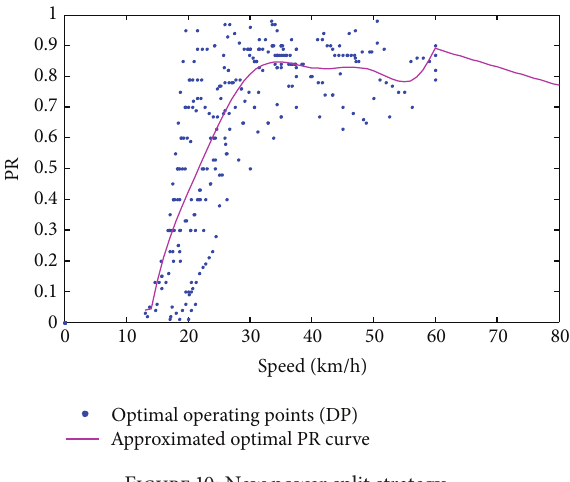
Figure 10: New power split